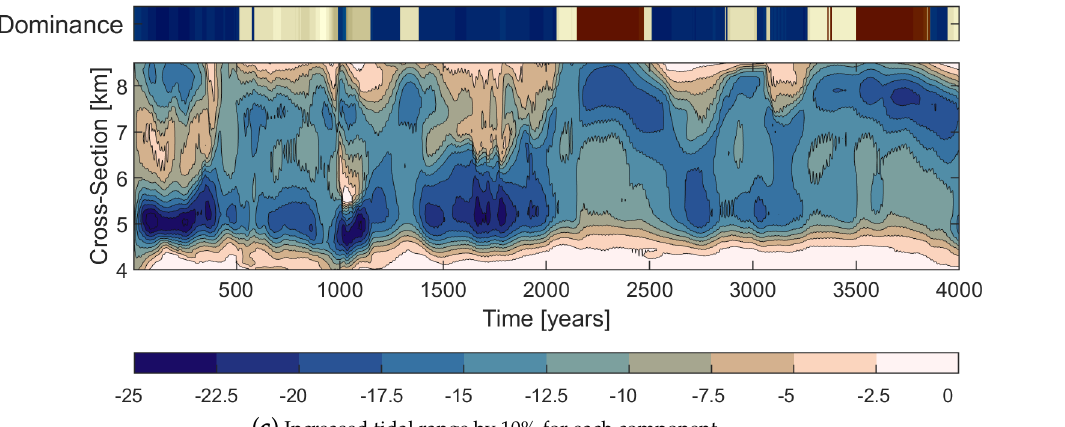
Figure 8. Two-channel system alternation for the tidal scenario simulations (description, see Figure